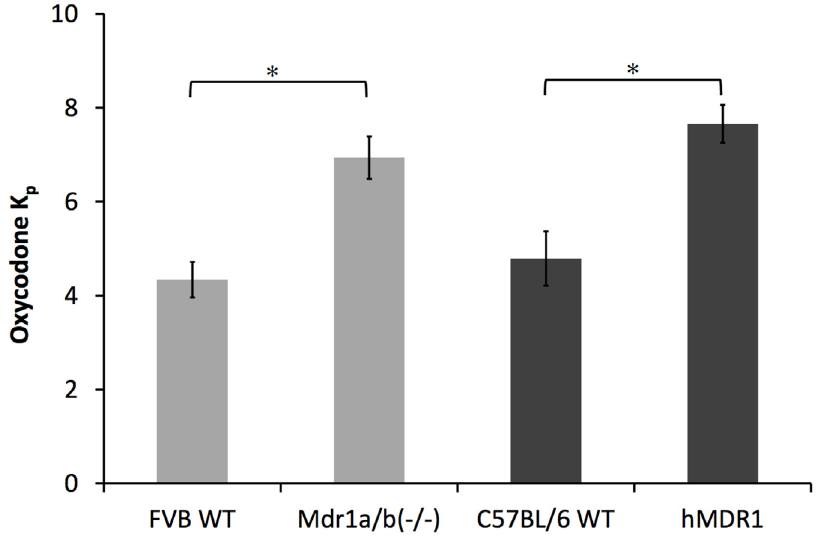
Fig 3. Comparison of K p between the Mdr1a/1b(-/-) mice with FVB WT controls and hMDR1 mice with C57BL/6 WT controls for oxycodone ( * p < 0.05, ** p < 0.01). Oxycodone was administered 1 mg/kg subcutaneously (n = 3).